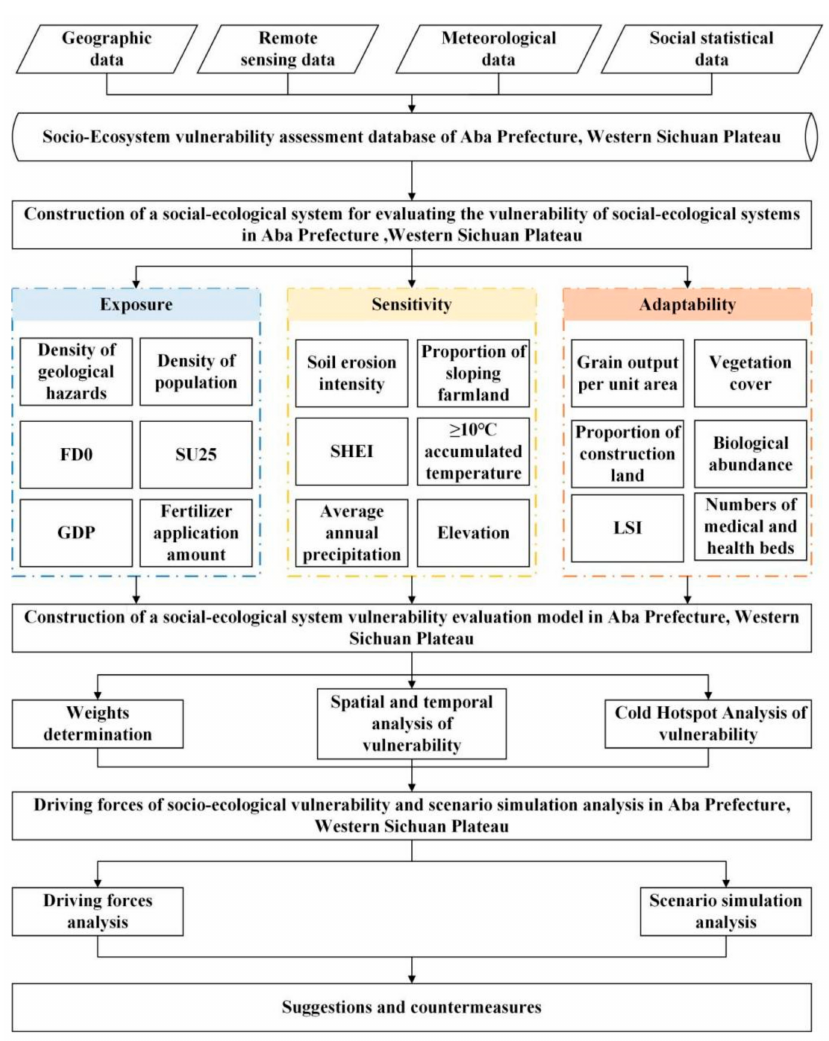
Figure 2. Research technology